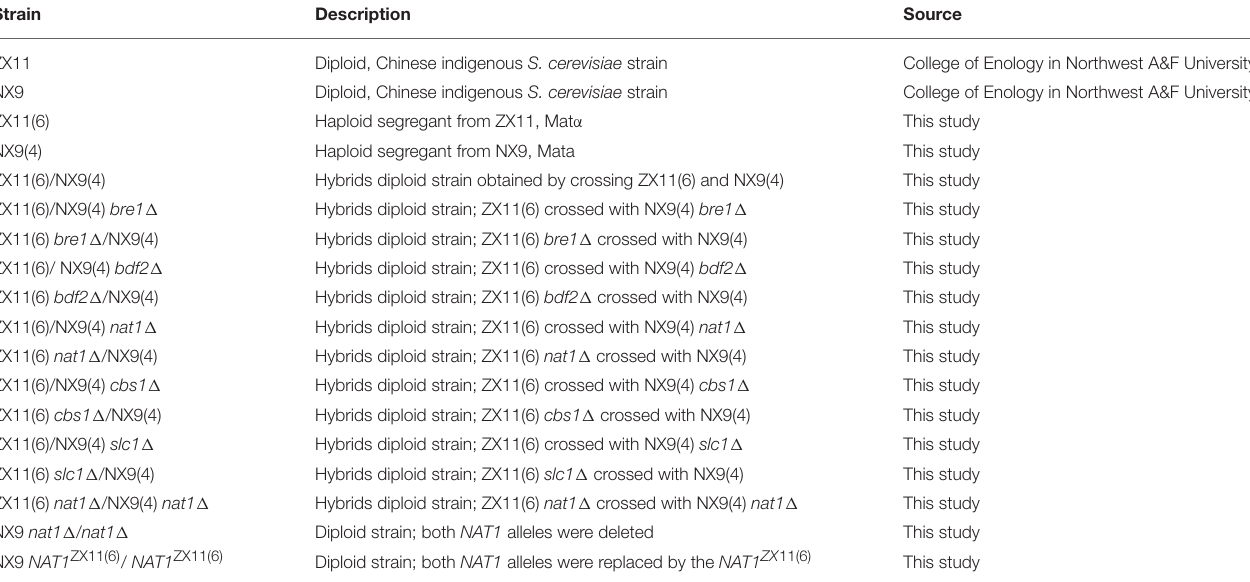
TABLE 1 | The main S. cerevisiae strains used in this